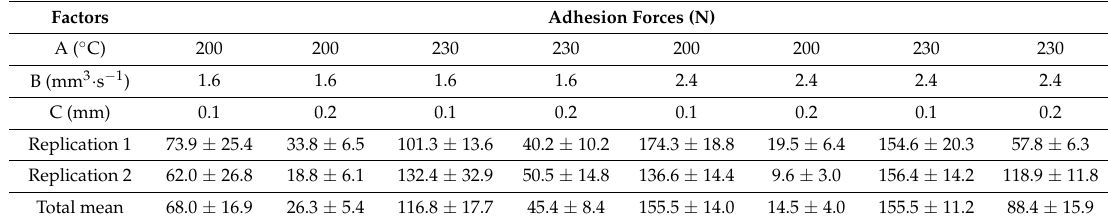
Table 2. Summary of all adhesion force results for the parametric investigation of the